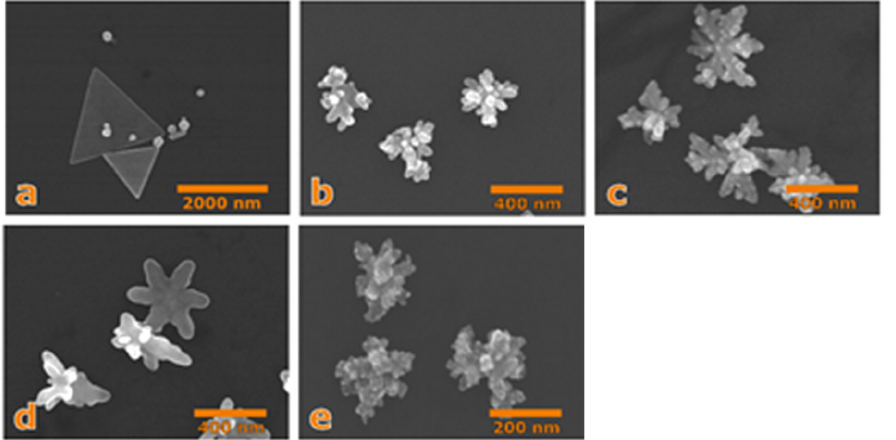
Figure 8. Typical nonspherical gold nanoparticles forming in the presence of poly-DADMAC: ( a , b ) 70 µM HAuCl 4 , 60 µM ascorbic acid, 100 ppm poly-DADMAC; ( c ) 70 µM HAuCl 4 , 60 µM ascorbic acid, 250 ppm poly-DADMAC; ( d ) 70 µM HAuCl 4 , 60 µM ascorbic acid, 400 ppm poly-DADMAC; ( e ) 50 µM HAuCl 4 , 100 µM ascorbic acid, 60 ppm poly-DADMAC, 10 ppm PSS. It is assumed that the effect of the poly-DADMAC is mainly related to the electro- static effect of macromolecules adsorbing onto the surface of growing nanoparticles. An excess of positive charge on particles during the growth process can lower the growth rates, on the one side. On the other side, it causes a self-polarization effect in the case of nonspherical particles. This could be the reason for the preferential edge- and cor- ner-oriented growth of flat gold nanoprisms induced by an attractive Coulomb interac- tion between the positively polarized particle corners and the negatively charged tetra- chloroaurate. The formation of nonspherical, star-like and special-shaped crystalline gold nanoparticles [31–33] depends on the empirically optimized composition of reaction so- lutions and is known to be related to symmetry breaking during nanoparticle formation [47]. 4. Conclusions The investigations confirm the fact that the addition of the polycationic wa- ter-soluble polymer poly-DADMAC causes significant changes in the growth and ag- gregation behavior of gold nanoparticles. The charged polymer is responsible for the modulation of nucleation and growth rate of gold nanoparticles, as well as for their in- teraction and incorporation in larger clusters and assemblies. As a result, different types of nanoparticle aggregates with sizes between about 20 nm and several microns are formed. SEM images suggest at least three different aggregation levels of nanoparticles can be distinguished, which can be described as hierarchically organized aggregate structures. The shapes and sizes of nanoparticle structures can be controlled by the concentra- tion ratios of the metal precursor, the reducing agent and the macromolecular additives. Thus, nanoparticle assemblies with a dendritic structure and high specific surface area can be generated. These particles are of interest for catalytic and analytical applications such as plasmonic sensing and surface-enhanced Raman scattering (SERS). The cyclic photospectrometric measurements do not reflect a sedimentation of aggregates after 15